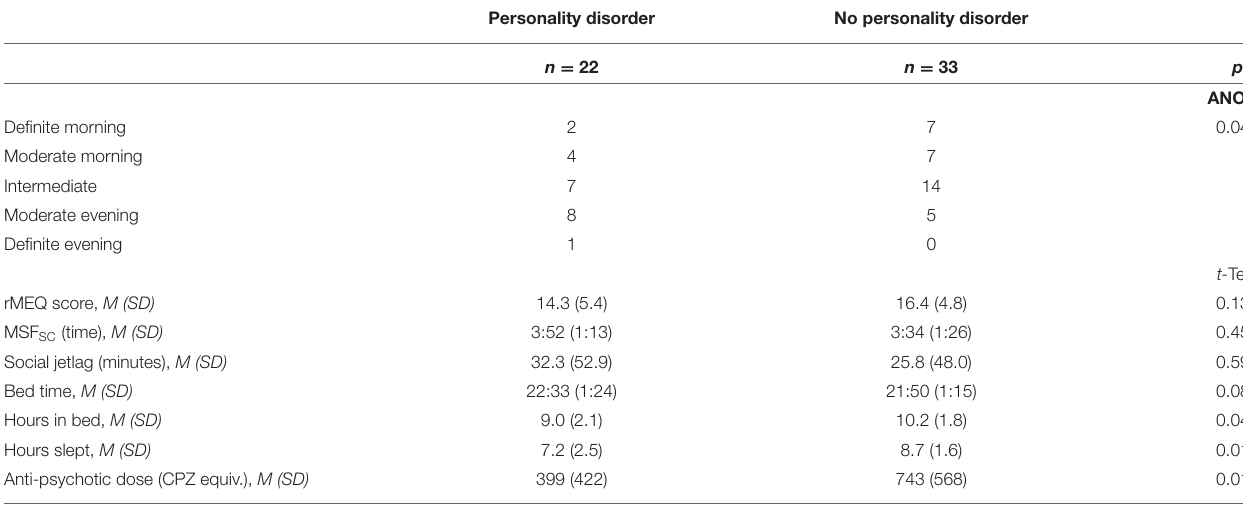
TABLE 3 | Differences in chronotype, anti-psychotic medication, hours slept, hours spent in bed, and rMEQ scores for personality disorder and no personality disorder groups. Personality disorder No personality disorder